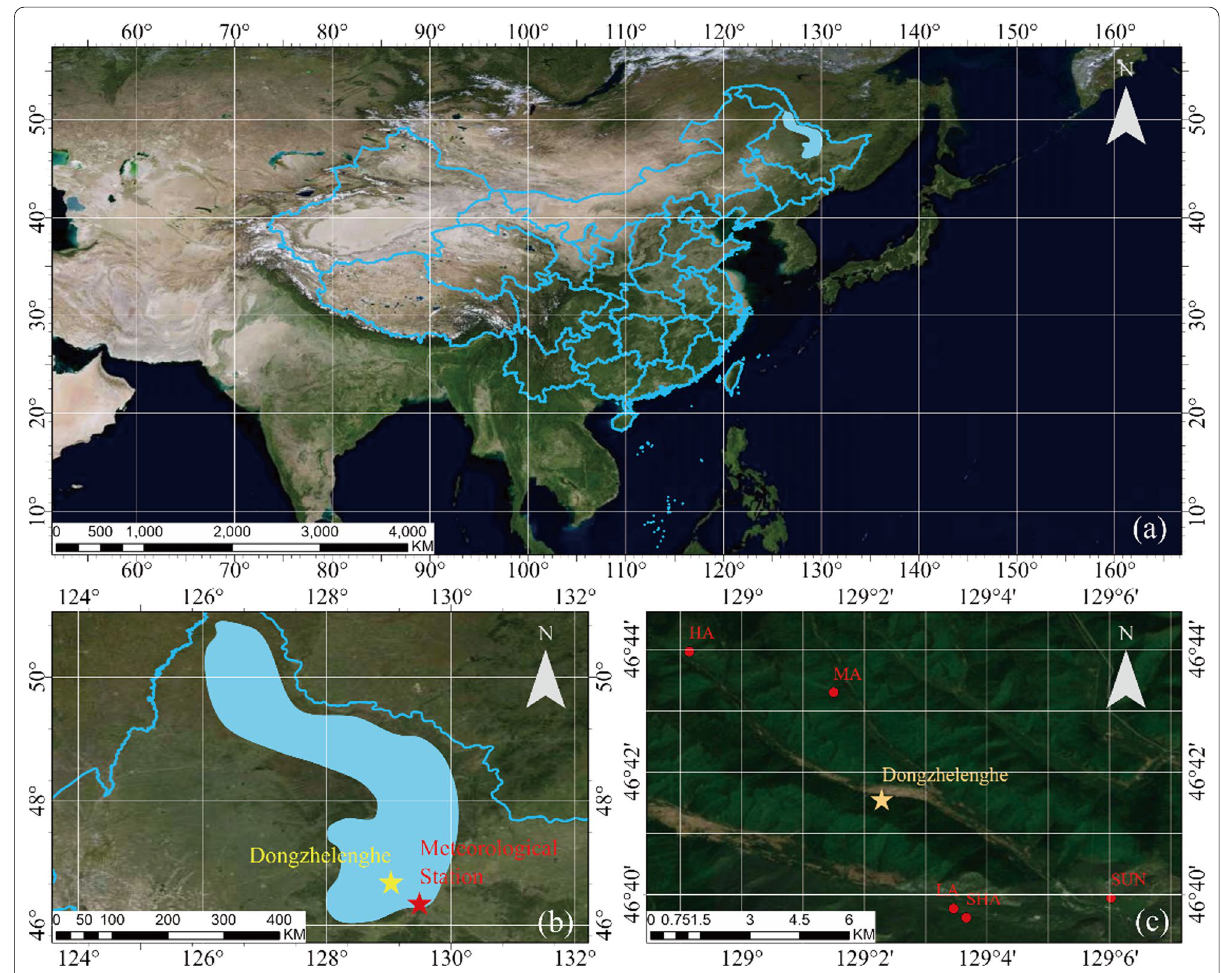
Fig. 1 Location and distribution of the sampling sites in the southern Lesser Khingan Mountains, Northeast China. a Location of the study area; b Yilan Meteorological Station; c Distribution of the sampling sites. Sampling sites are abbreviated as LA (Low altitude), MA (Middle altitude), HA